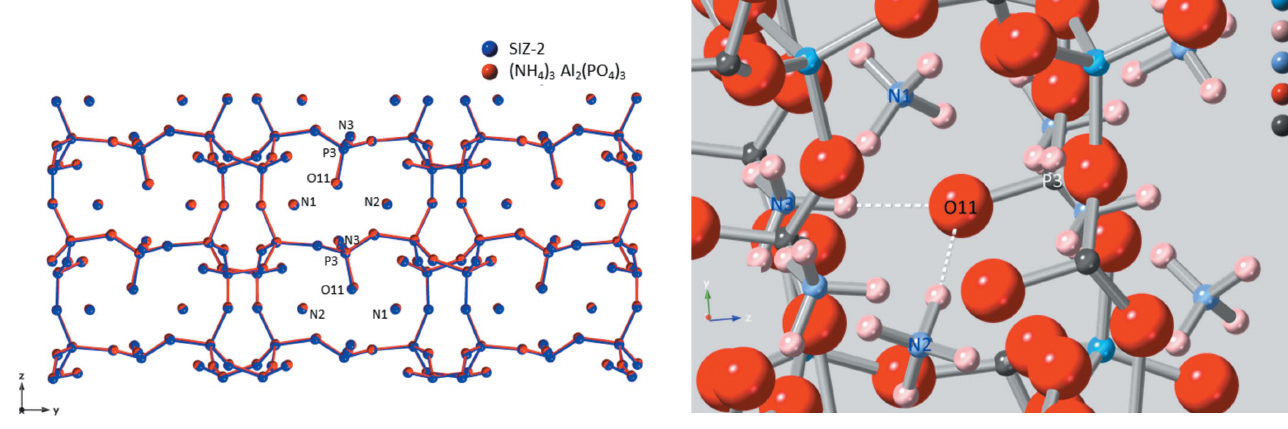
Figure 4 Ball and stick representation of the key area surrounding O11 where the largest position movement takes place in the two independent refinements of (NH 4 ) 3 Al 2 (PO 4 ) 3 .